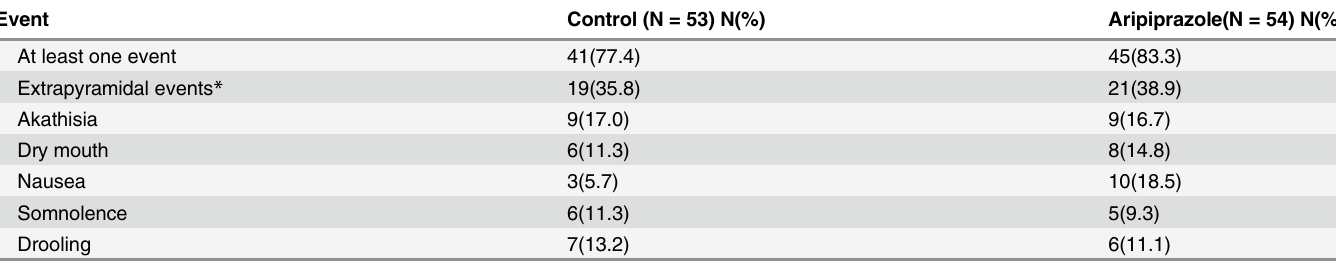
Table 3. Adverse events observed in the study (incidence (cid:1)